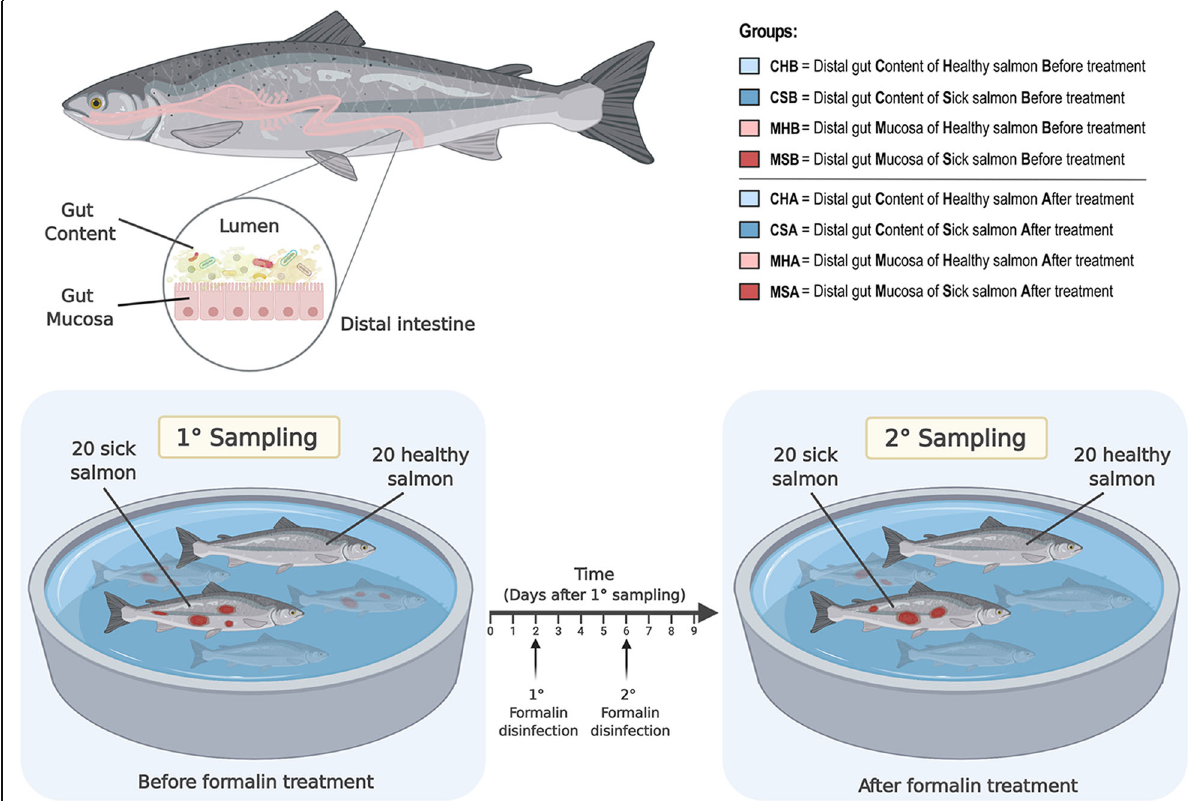
Fig. 1 Experimental design and types of samples collected. A total of 80 salmon were sampled, 40 before and 40 after formalin treatment, in both cases, 20 healthy and 20 sick fish were selected (bottom). Two different types of samples, distal gut content and distal gut mucosa, have been collected for each fish (top-left panel), for a total of 160 samples. According to the experimental design for samples collection, eight groups of 20 samples can be recognized as described in the top-right legend: CHB = Distal gut Content of Healthy salmon Before treatment, CSB = Distal gut Content of Sick salmon Before treatment, MHB = Distal gut Mucosa of Healthy salmon Before treatment, MSB = Distal gut Mucosa of Sick salmon Before treatment, CHA = Distal gut Content of Healthy salmon After treatment, CSA = Distal gut Content of Sick salmon After treatment, MHA = Distal gut Mucosa of Healthy salmon After treatment, MSA = Distal gut Mucosa of Sick salmon After treatment. (Created with